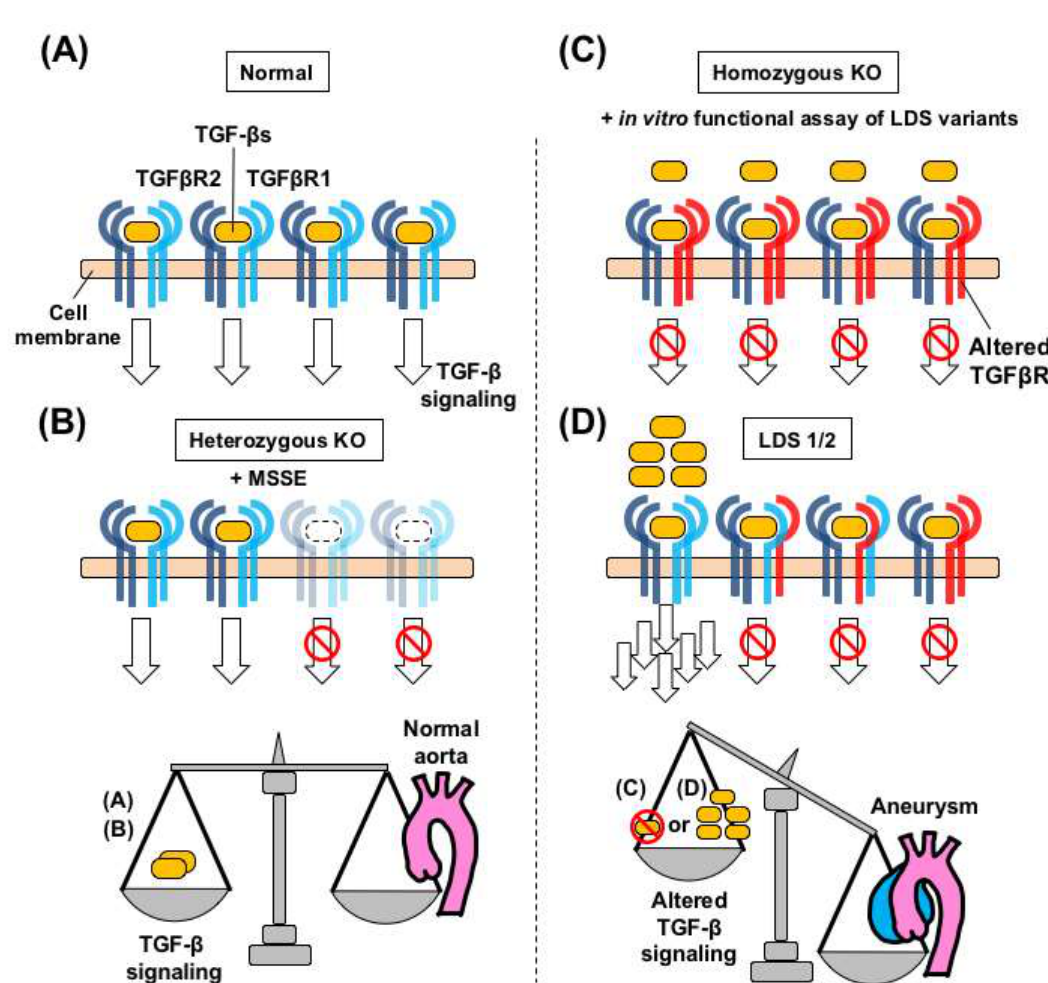
Figure 4. Dysregulated TGF- β signaling and aortopathy in Loeys-Dietz syndrome (LDS) and related genetic models. ( A ) Each TGFBR1 and TGFBR2 STK acts as a homodimer on the cell membrane in a normal aorta. ( B ) Basal levels of TGF- β signaling, through the wild-type/wild-type receptors, are maintained, in heterozygous Tgfbr1 and Tgfbr2 knock-out (KO) mice. This scheme holds true in patients with MSSE carrying truncating pathogenic variants in the STK domain of TGFBR1, who do not develop aortic aneurysms [91]. ( C ) Postnatal homozygous TGF- β receptor knockout mice, such as Myh11-CreERT2.Tgfbr2 f/f [70], develop aortic aneurysms without activation of intracellular TGF- β signaling. This signaling landscape holds true in in vitro functional assays of LDS variants. ( D ) In LDS patients with loss-of-function variants, over-secreted TGF- β can be transmitted through homodimers of the remaining wild-type TGFBR homodimer complex. Dysregulated TGF- β signaling in the aortic wall is associated with aneurysmal formation, but the molecular processes leading to such aneurysms may be different, depending on the genetic conditions and animal models used.